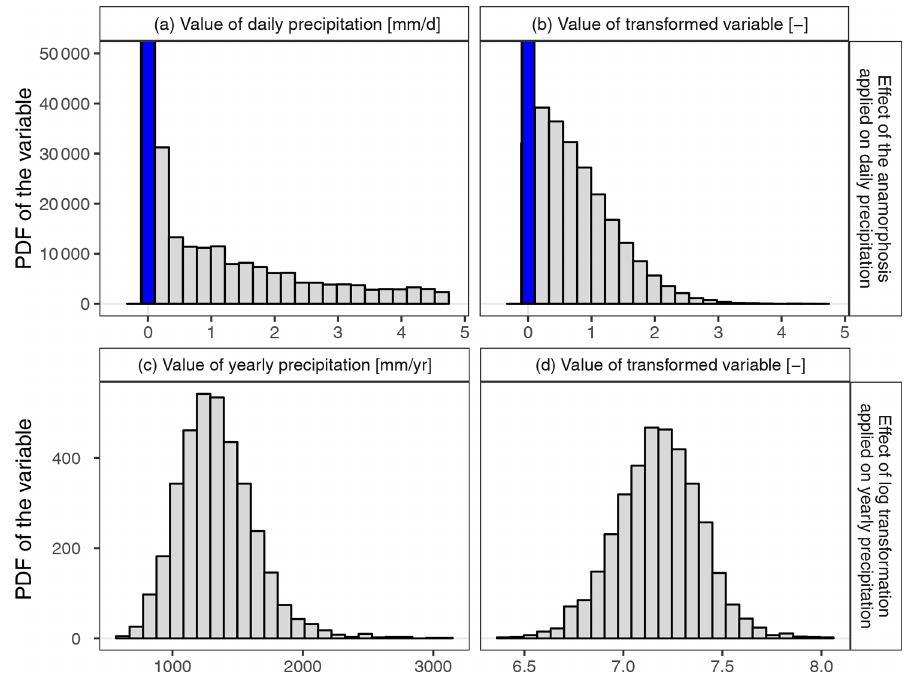
Figure 3. Schematic view of the transformations applied to SCOPE Climate daily (a, b) and yearly (c, d) precipitation for the case study cell during the 1958–2008 period. The blue line represents zero values. For daily precipitation the x -axis of panels (a) and (b) is truncated at 5mmd − 1 for